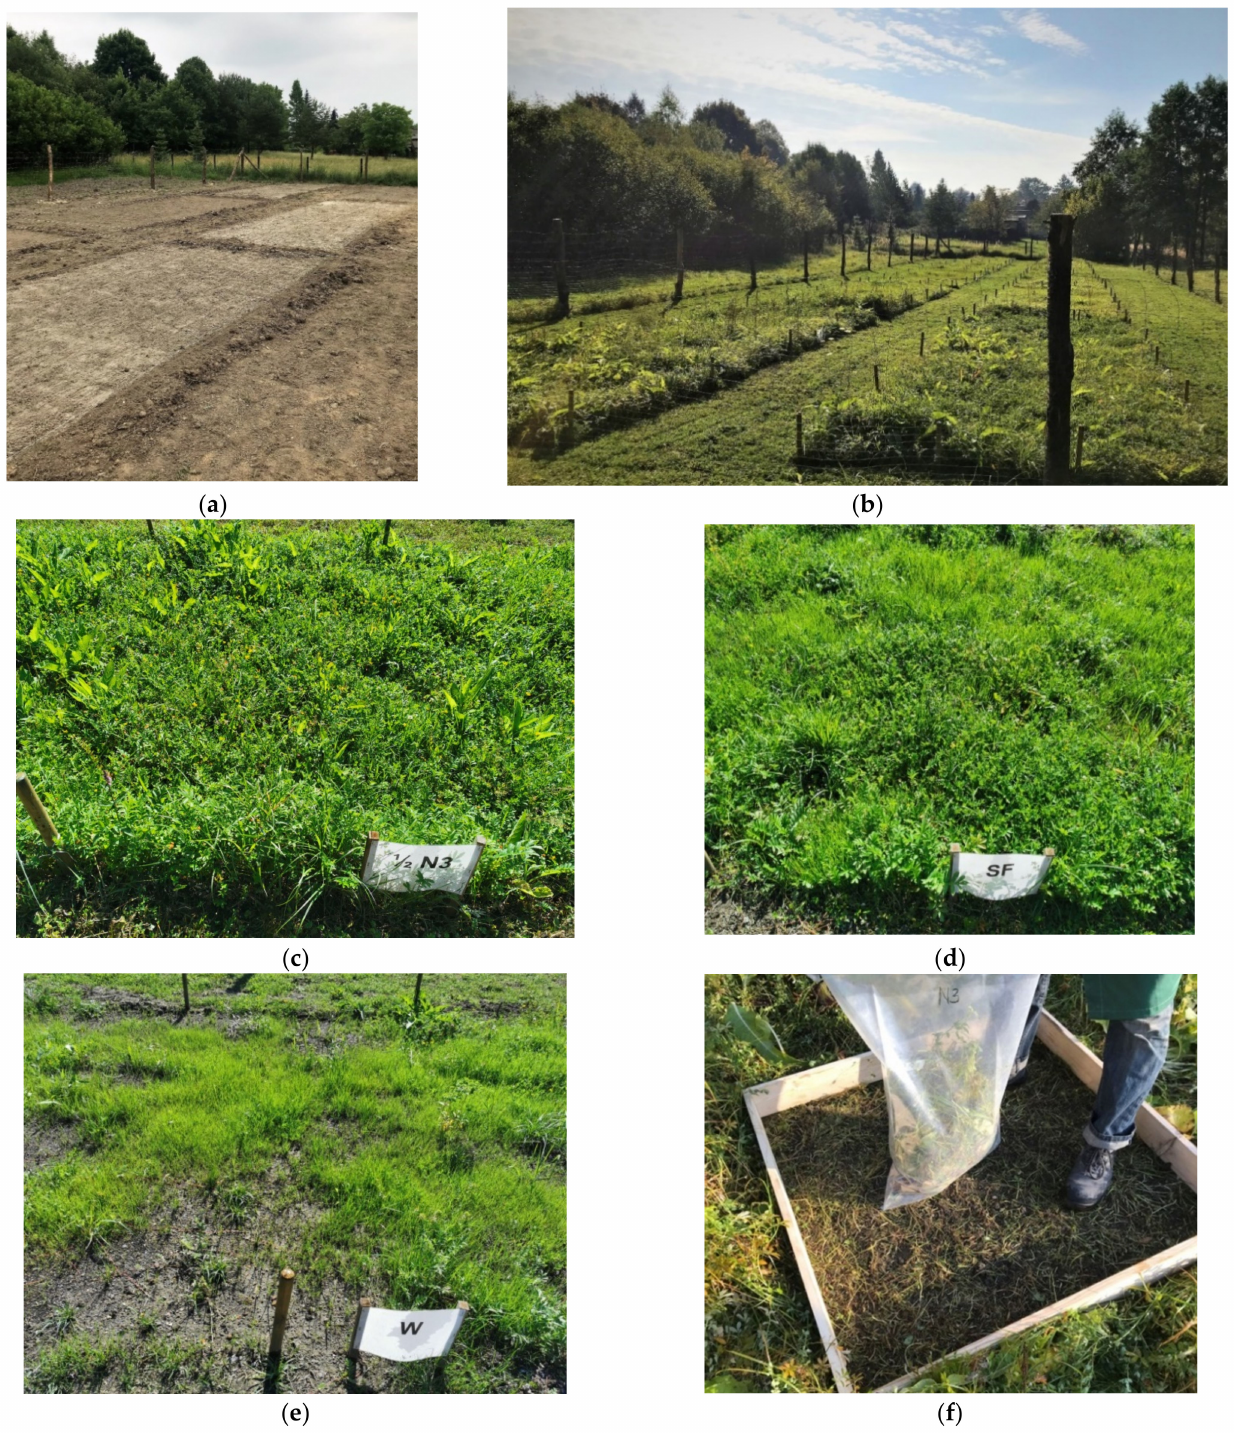
Figure 9. Field cultivation: ( a ) sown plants; ( b ) biomass growth in the plots; ( c ) biomass growth in test F4; ( d ) biomass growth in test F3, ( e ) biomass growth in test F1, ( f ) biomass collection from each plot. Explanation: test symbol according to Table